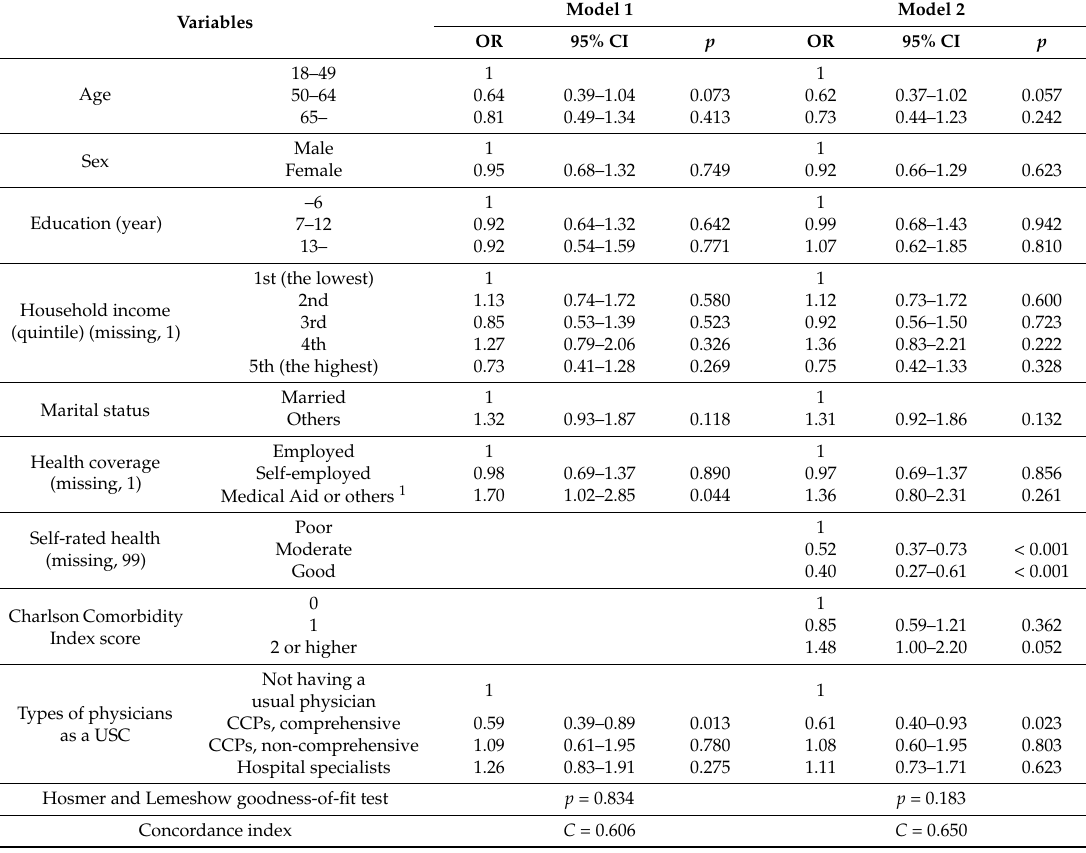
Table 3. Association between having a comprehensive community clinic physician (CCP) as a usual source of care and the experience of emergency department (ED) visits within a year in adults ( ≥ 18 years) with hypertension—based on the 2013 Korea Health Panel